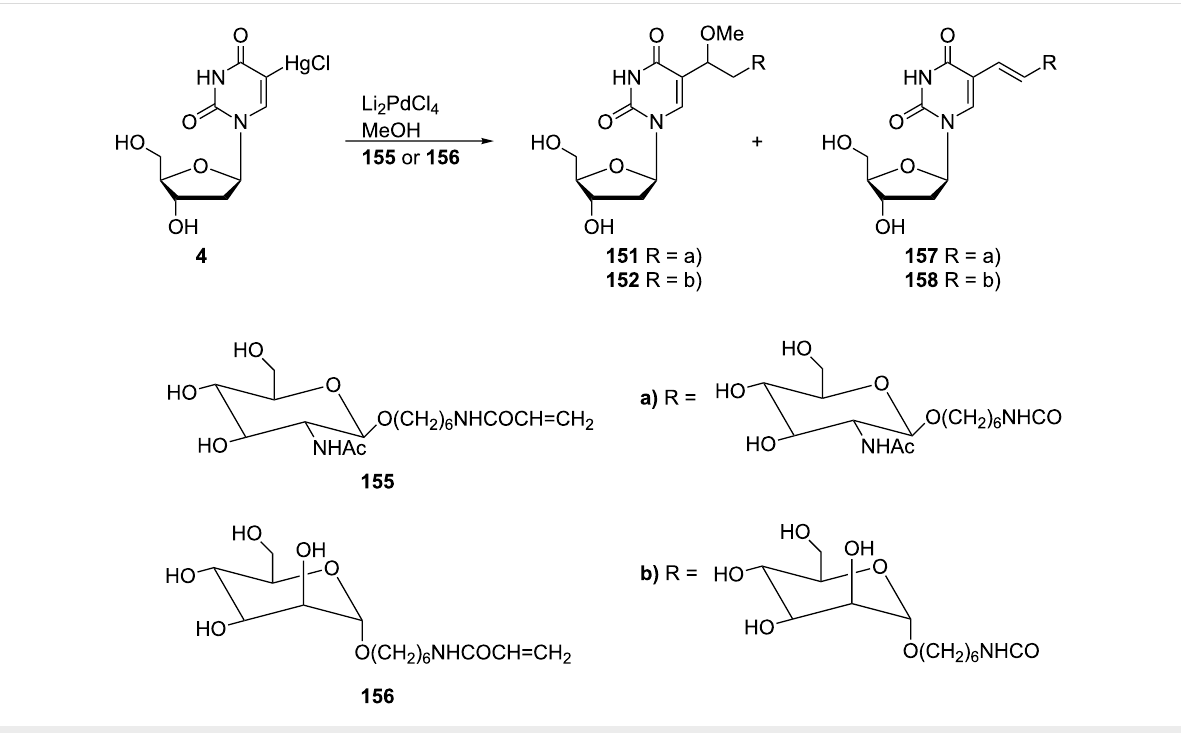
Scheme 26: Synthesis of 2'-deoxyuridine derivatives 151 – 152 .